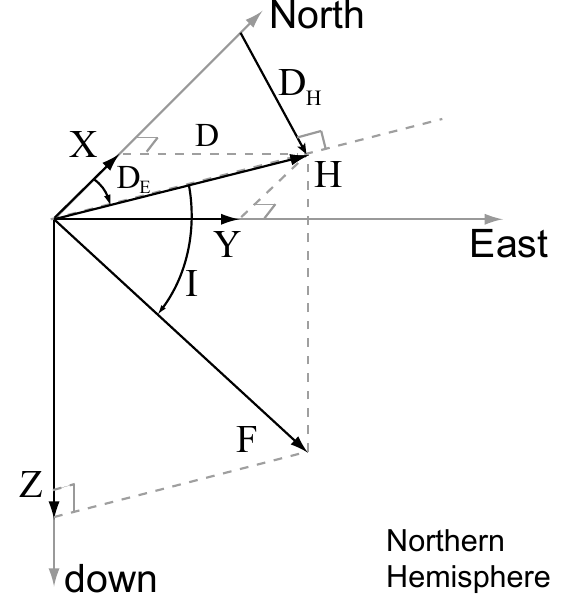
Fig. 5. Definition of magnetic elements. F is the total magnetic field vector; I is the inclination in degrees; D E is the declination in degrees; D is the declination in nanoteslas; D H is the horizontal component in the easterly direction perpendicular to H in nanotes- las; H is the horizontal component along the magnetic meridian in a northerly direction in nanoteslas. X, Y, and Z are the magnetic components in the geographic coordinate system (WGS84) in nan- oteslas. All vectors are shown in their respective positive